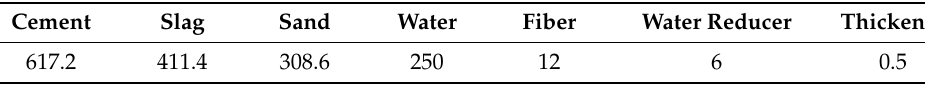
Table 3. ECC mixing proportions (kg/m 3